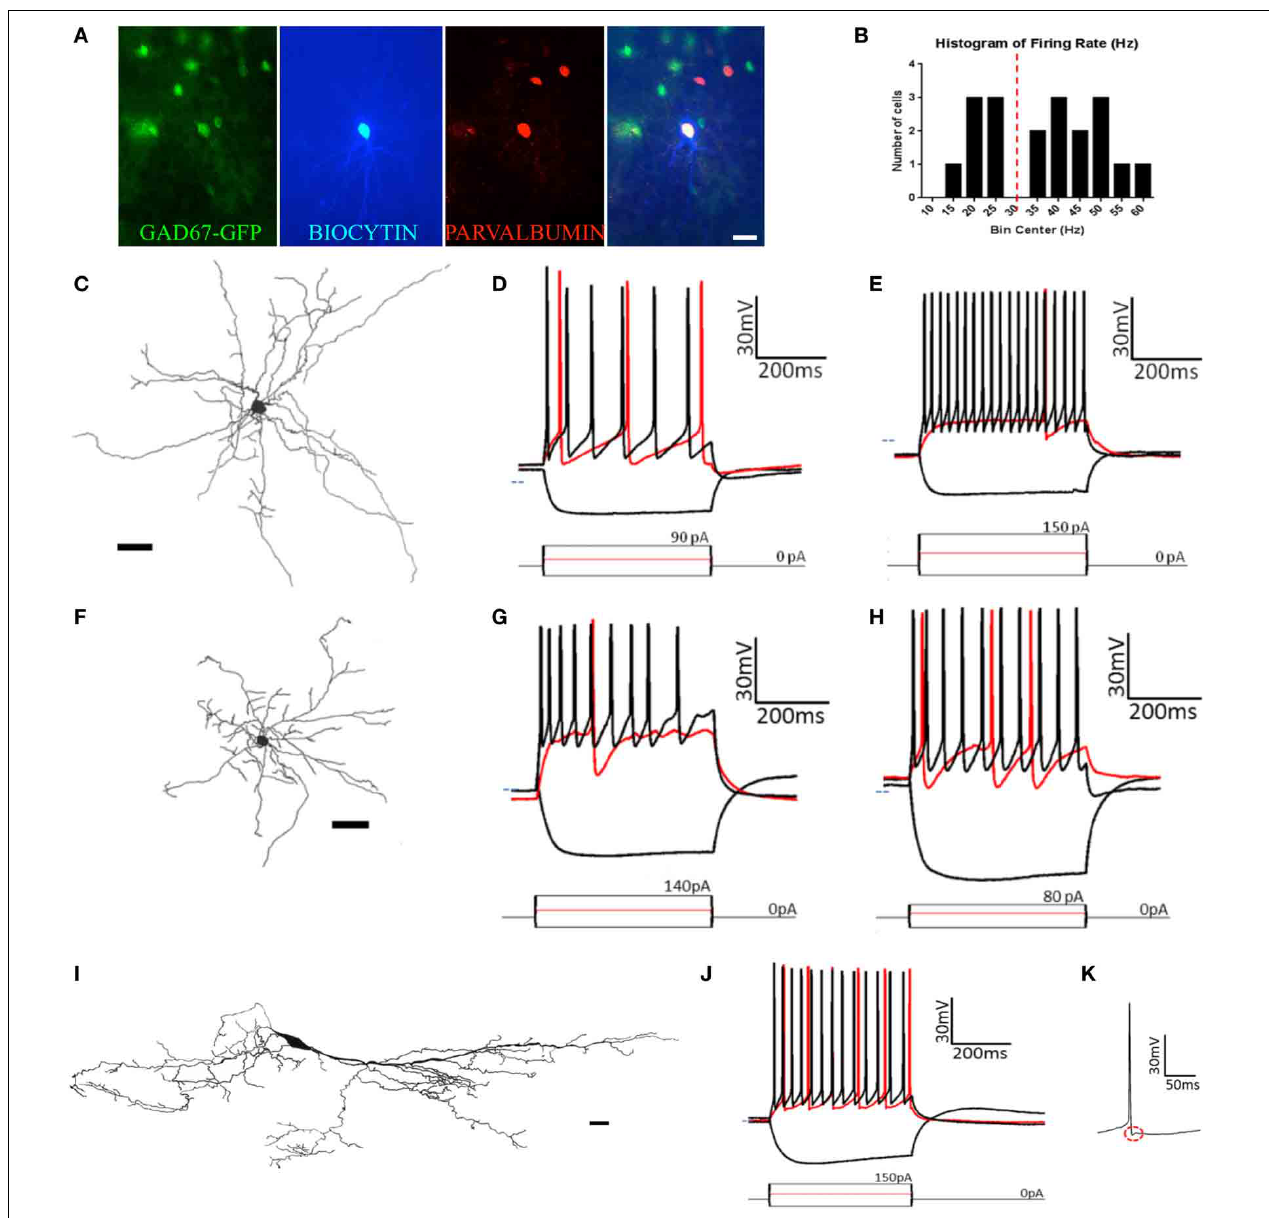
FIGURE 6 | At least five types of non-pyramidal cells are found in pars principalis. (A) Post-hoc immunohistochemistry of a GAD67-GFP + multipolar cell filled with biocytin after patch-clamp recording and subsequently stainined for parvalbumin. The merged image (far right) confirms the multipolar cell to be GAD67 + and PV + . Scale bar = 100 µ m. (B) Histogram of the bimodally distributed firing rates of multipolar cells in the sample. Dashed red line shows 30Hz as the boundary between regular-spiking and fast-spiking. (C,F,I) Cameralucida